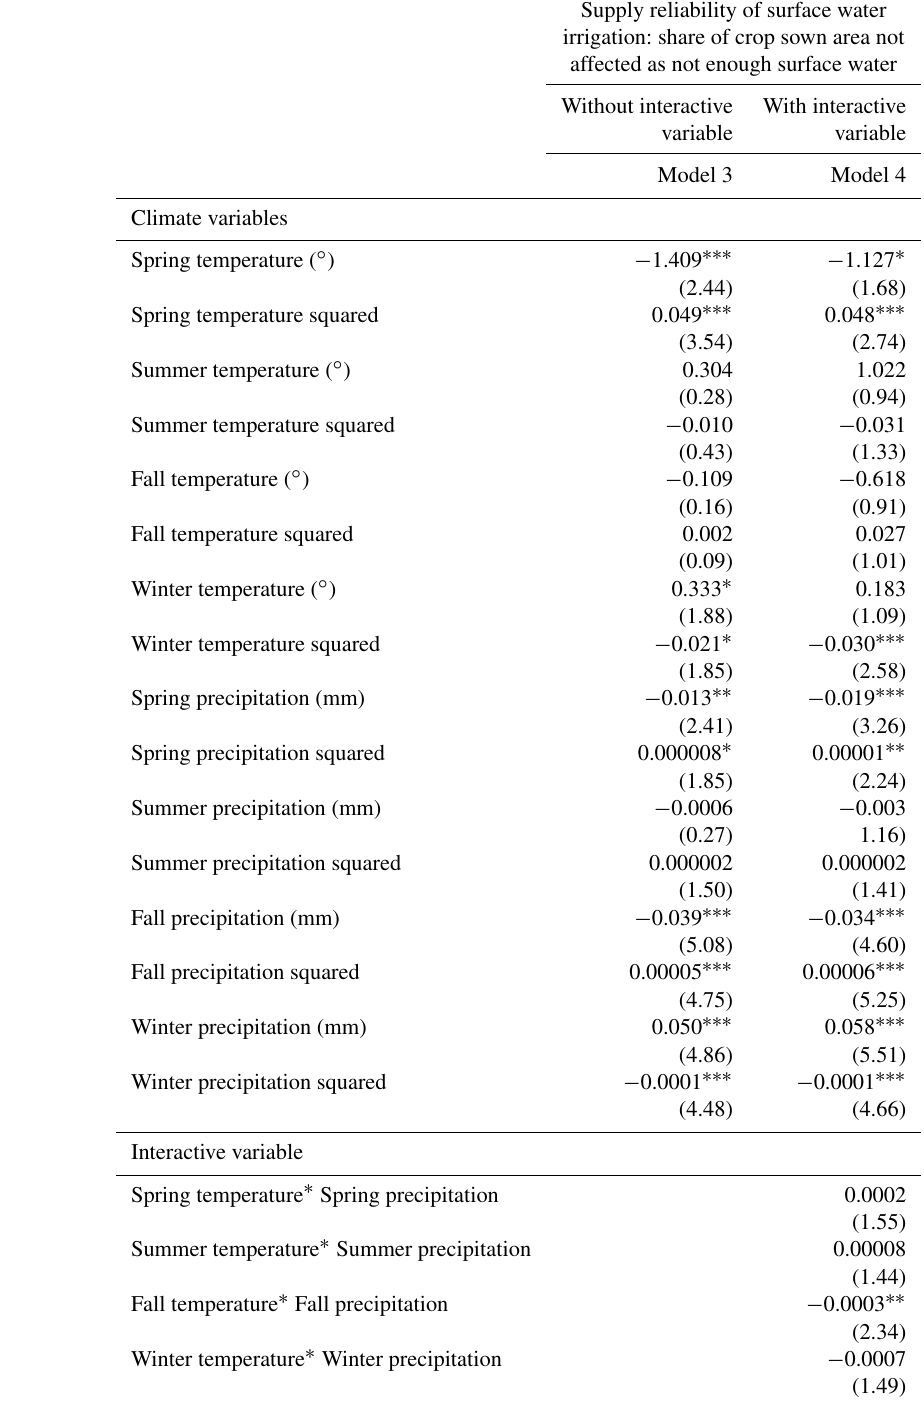
Table 4. Marginal effects of the determinants of the supply reliability of surface water irrigation from regression results of seasonal climate variables